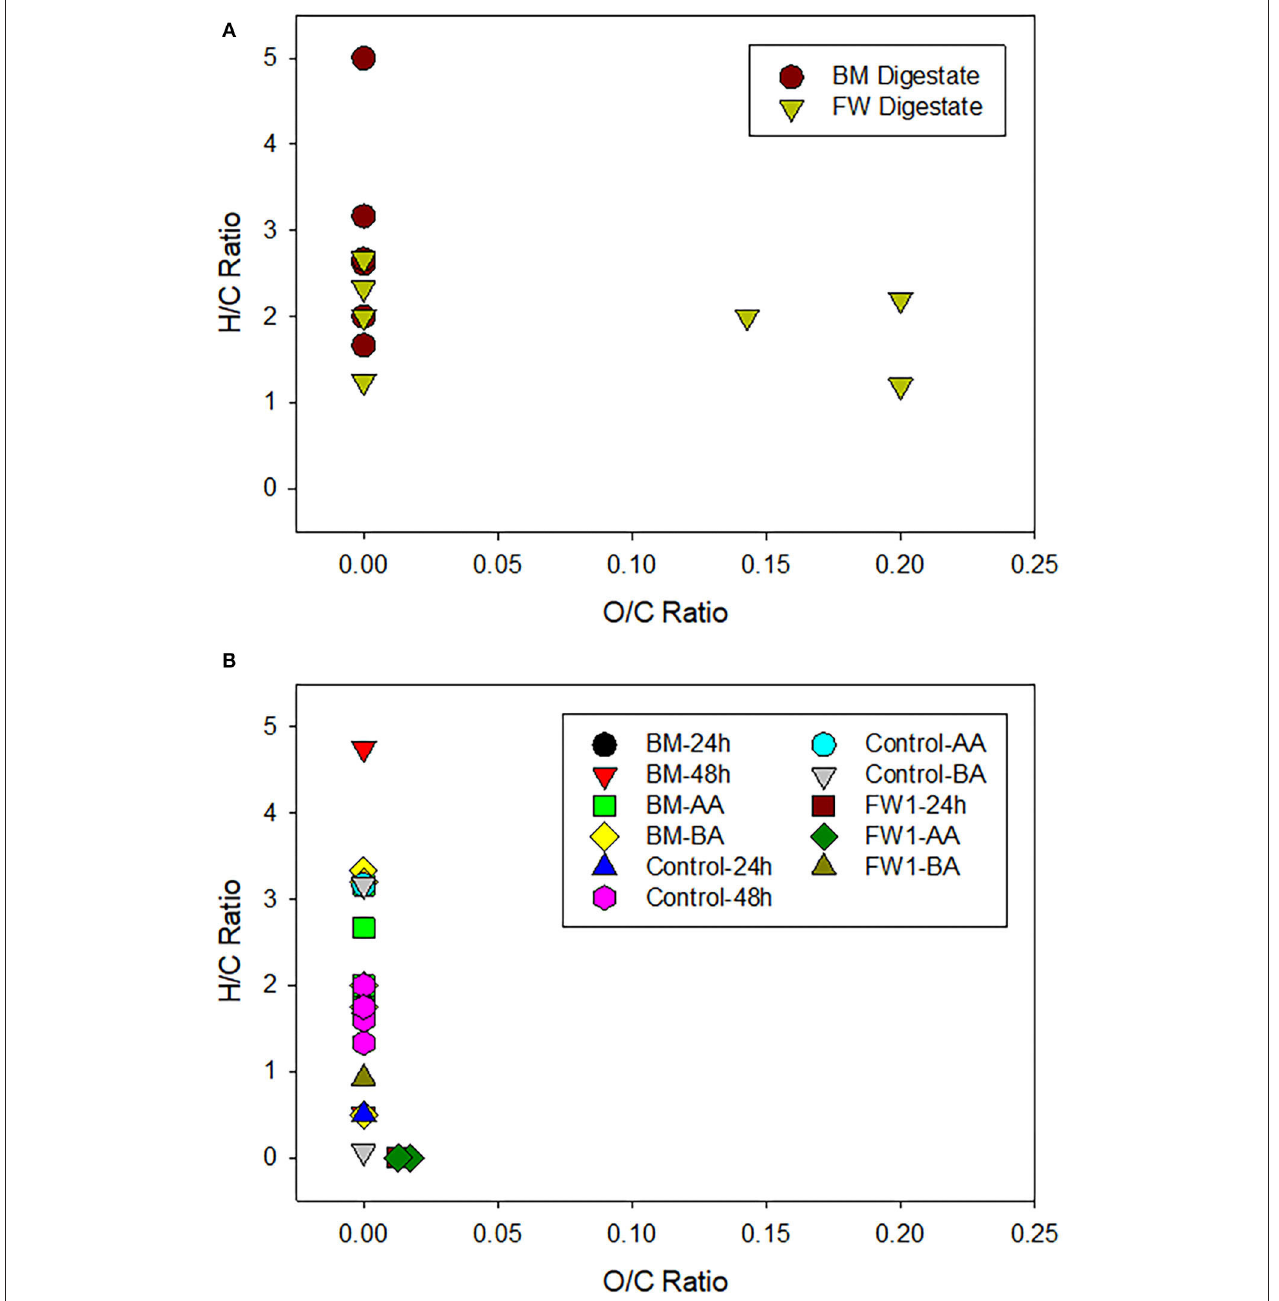
FIGURE 7 | Gas-chromatography/electron ionization mass-spectrometry (GC/EI-MS) analysis of (A) beer mash (BM) and food waste (FW) digestates amendments and (B) nutrient solutions sampled from controls (Not treated), BM, and FW treatments. Samples were taken before and after application (-BA and -AA), 24 and 48h after digestate application. O/C vs. H/C ratio of elemental formulas was plotted to provide an overview of the compound categories within each amendment. Data were assigned nominally into categories based on a van Krevelen empirically derived metabolite map depicting chemical compound classes and their relative boundaries as assigned in Figure 5 in Kim et al. (2003) study. FW-AA, FW-BA, and FW2 samples had values below detection-limit and are not reported here.